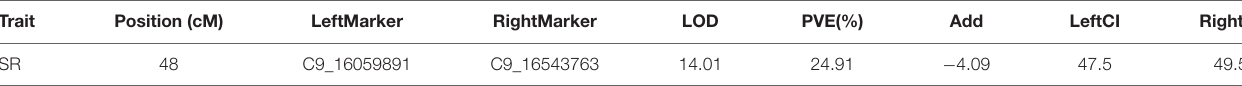
TABLE 2 | Identification of qCTBB9 for cold tolerance at bud-bursting stage by linkage analysis. Trait Position (cM) LeftMarker